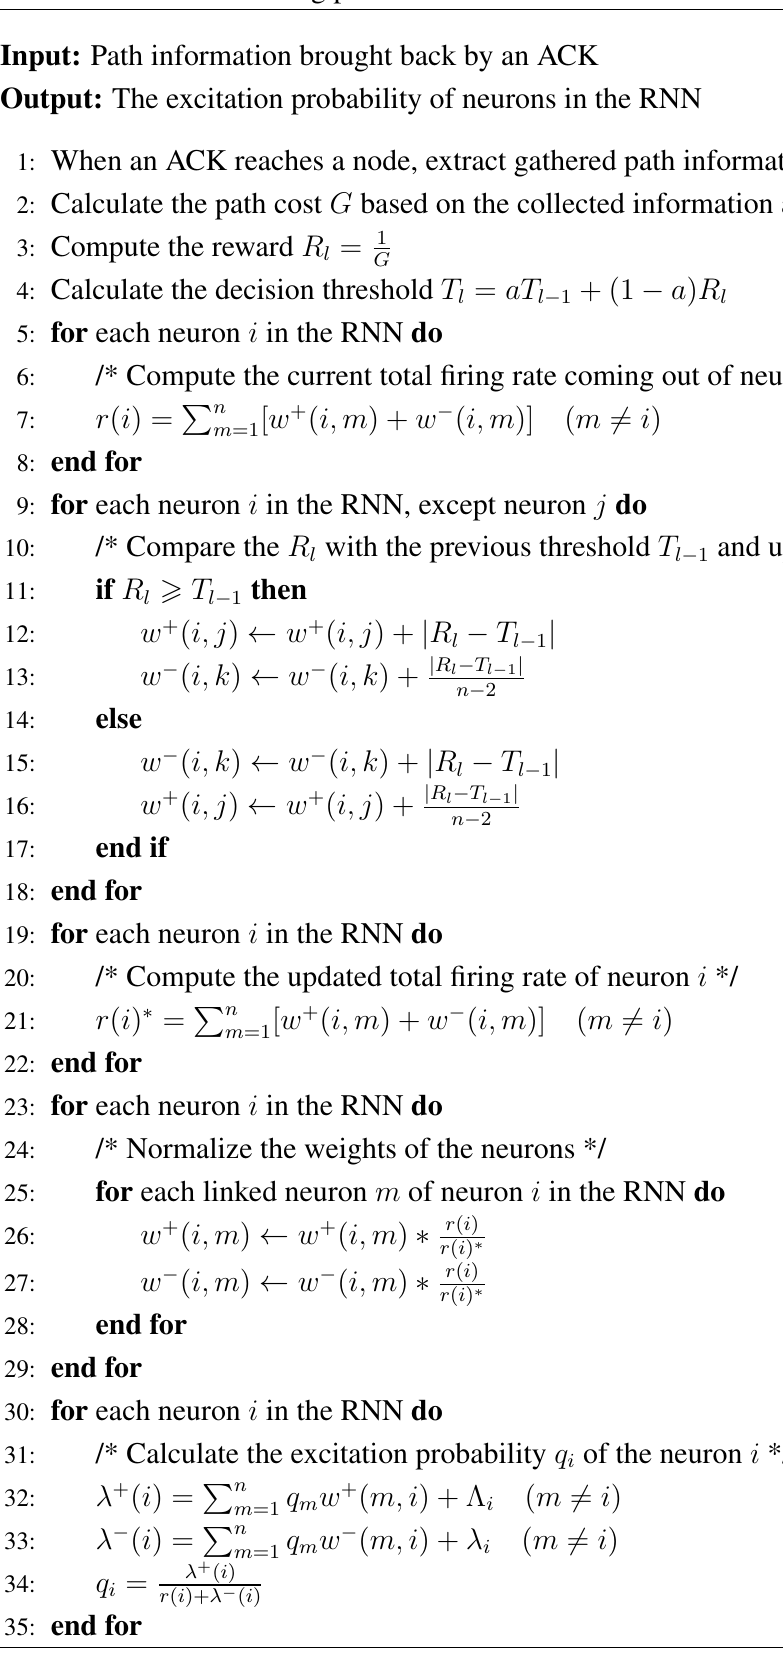
Pseudocode 1 The training process of